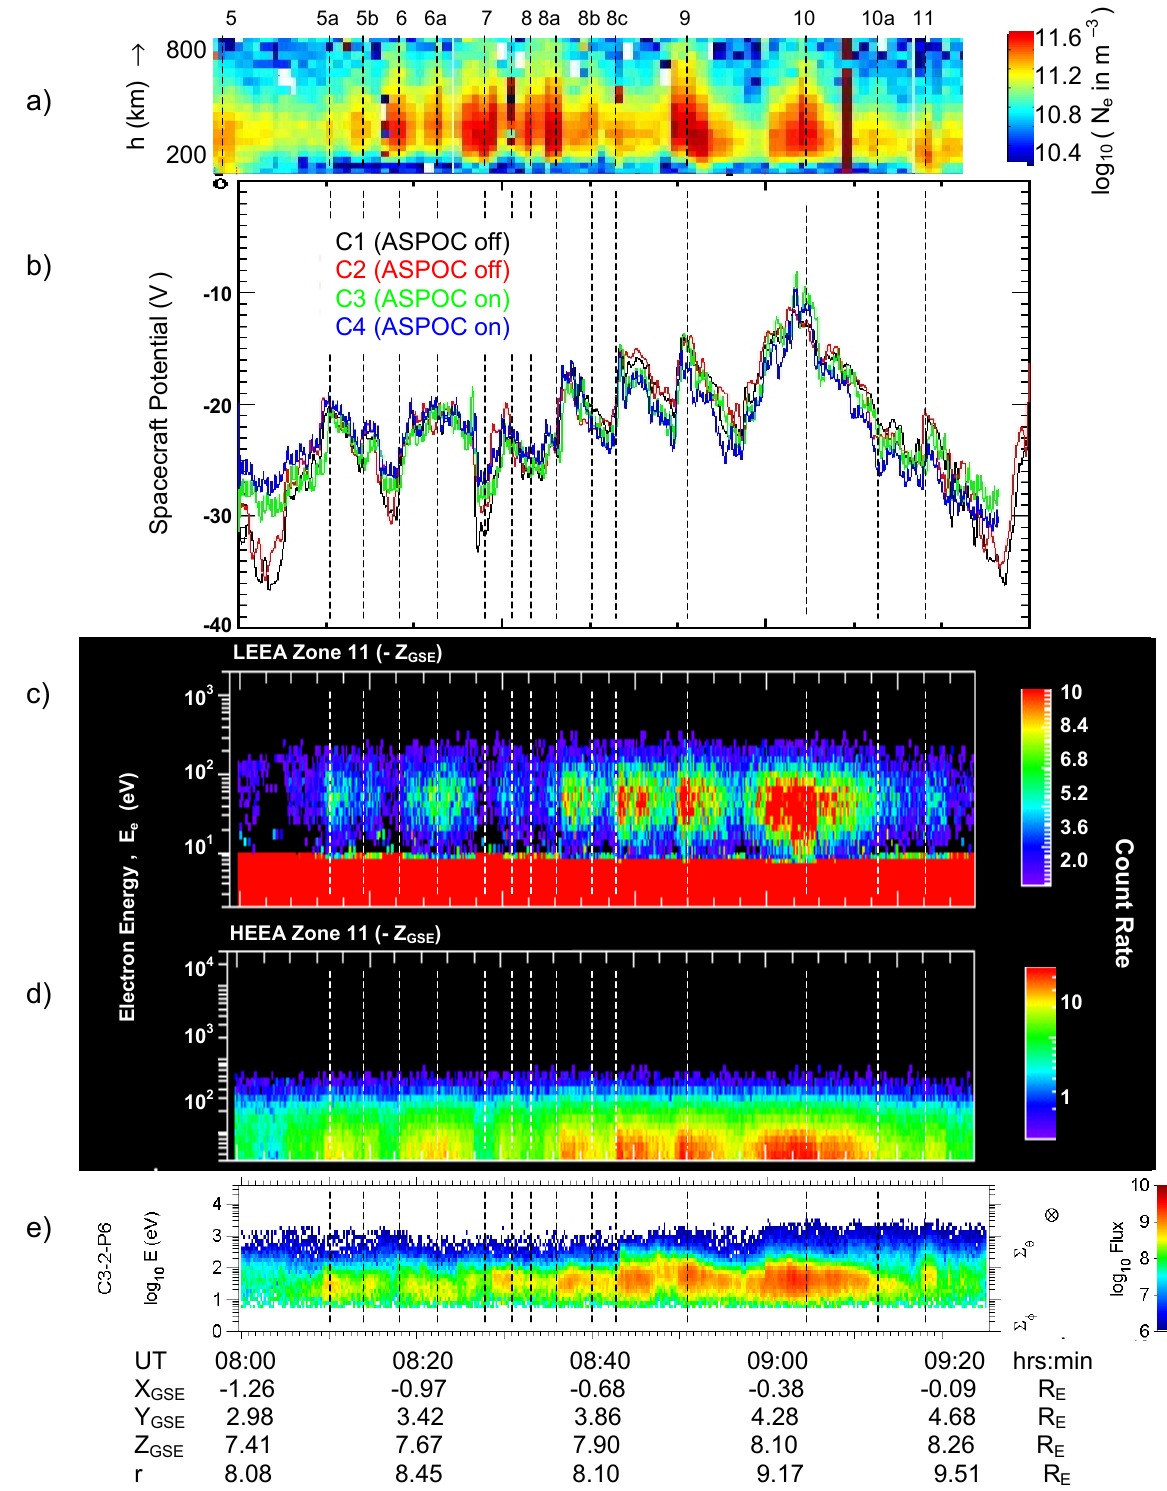
Fig. 10. From top to bottom: (a) the electron concentration observations by the field-aligned ESR beam, as shown in the top panel of Fig. 6, but shifted to earlier times to make events 5 and 11 agree. (b) potential measurements for all 4 spacecraft from the EFW instrument. (c) electron observations made by the HEEA detector of the PEACE instrument on the Cluster spacecraft 3 (C3); (d) electron observations made by the LEEA detector of the PEACE instrument on C3. In both (b) and (c), the particles seen are in zone 11 of the detector, which makes continuous observations of electrons moving in the + Z GSE direction. (e) ion observations made by the CIS instruments on board Cluster